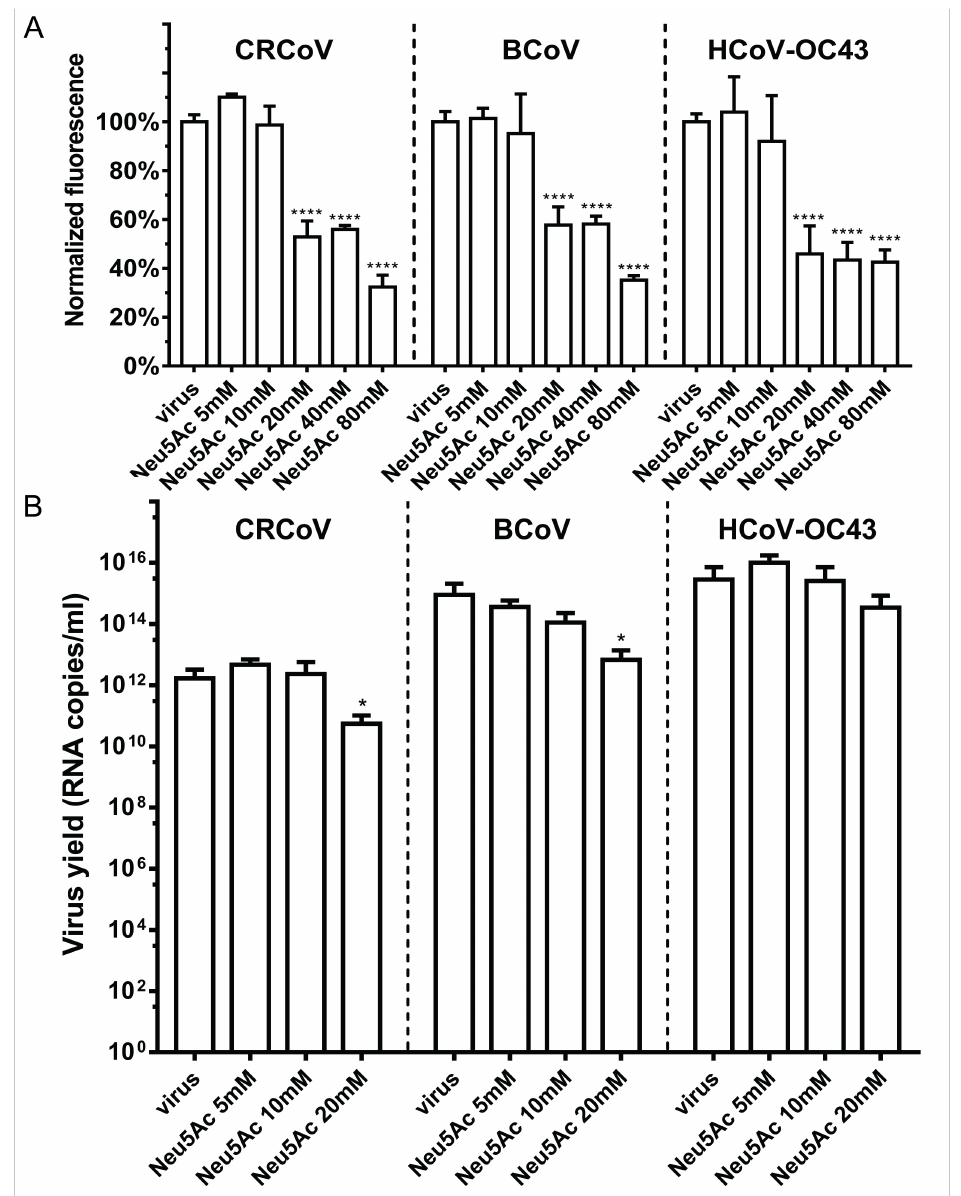
Figure 5. Soluble SAs limits attachment of HCoV-OC43 VR-1558, BCoV, and CRCoV but does not affect their replication. ( A ) Cells were overlaid with HCoV-OC43 VR-1558, BCoV, and CRCoV stocks preincubated with N -acetylneuraminic acid (Neu5Ac), incubated for 2 h at 4 ◦ C, fixed, and immunostained. Graph shows results of flow cytometry analysis of viral attachment; data are presented as mean fluorescence normalized to control. ( B ) Cells overlaid with viral stocks (at TCID 50 of 400 per milliliter, which approximately corresponds to M.O.I. = 0.0007) exposed to Neu5Ac were incubated for 2 h at temperature optimal for particular virus. Subsequently, unbound virions were washed off and cells were incubated for 5 days in the presence of Neu5Ac. The data is presented as mean ± SD of virus yield in cell culture supernatant (RT-qPCR) from at least three experiments in triplicate. (* p < 0.05; ** p < 0.01; *** p < 0.001; **** p <